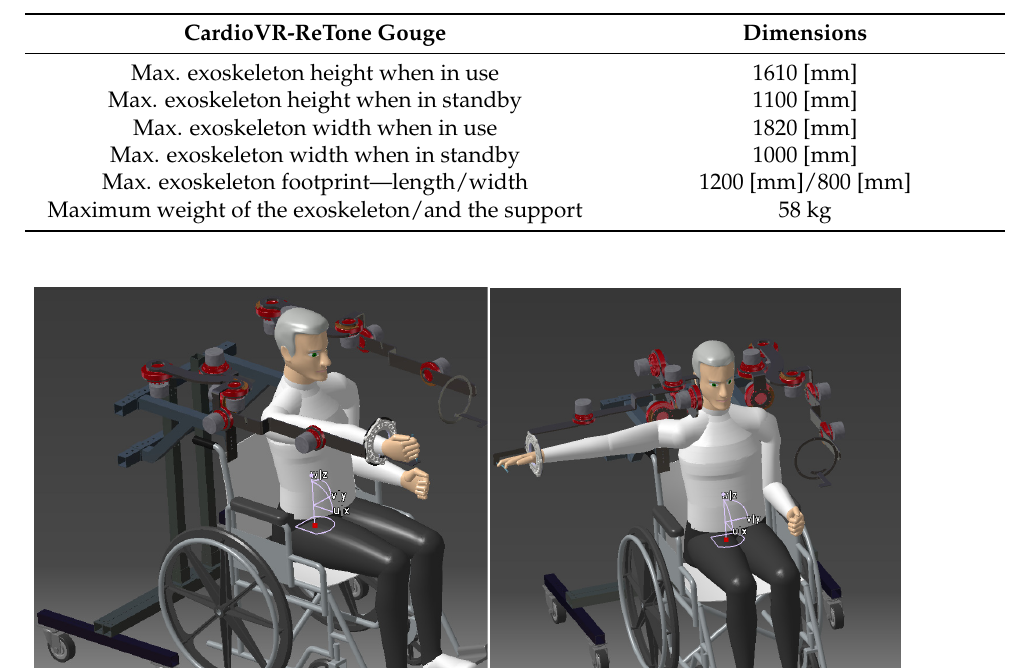
Table 1. Technical characteristic of CardioVR-ReTone.